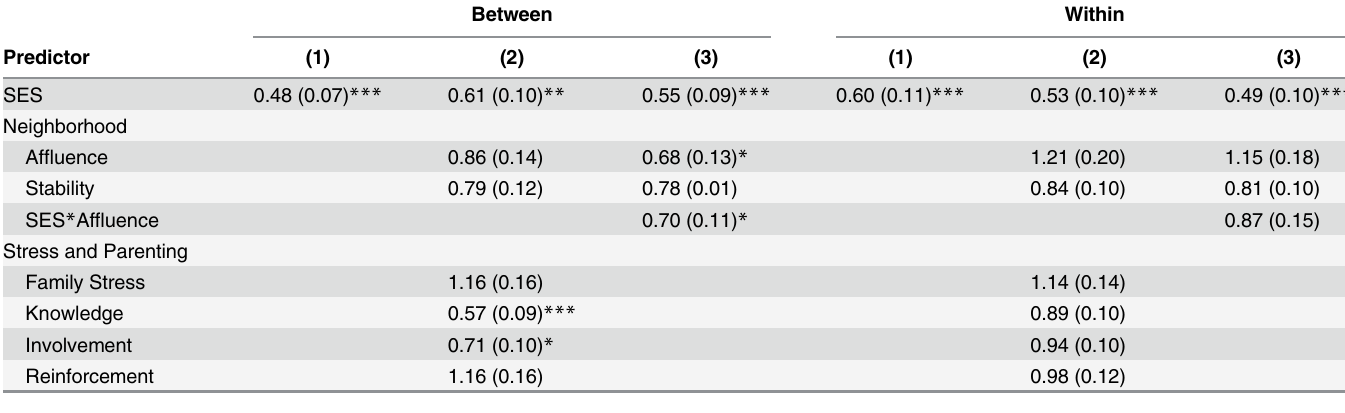
Table 5. Regression Models for Serious Delinquency. Note . Odds ratios with standard errors in parentheses. Control variables omitted from table: single caretaker, ethnicity, age dummies, and wave dummy. Between Within